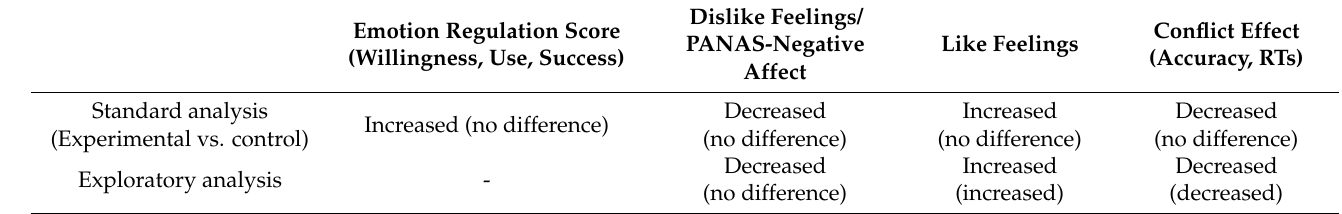
Table 1. Summary of the expected and actual (indicated in brackets) outcome for the standard and exploratory